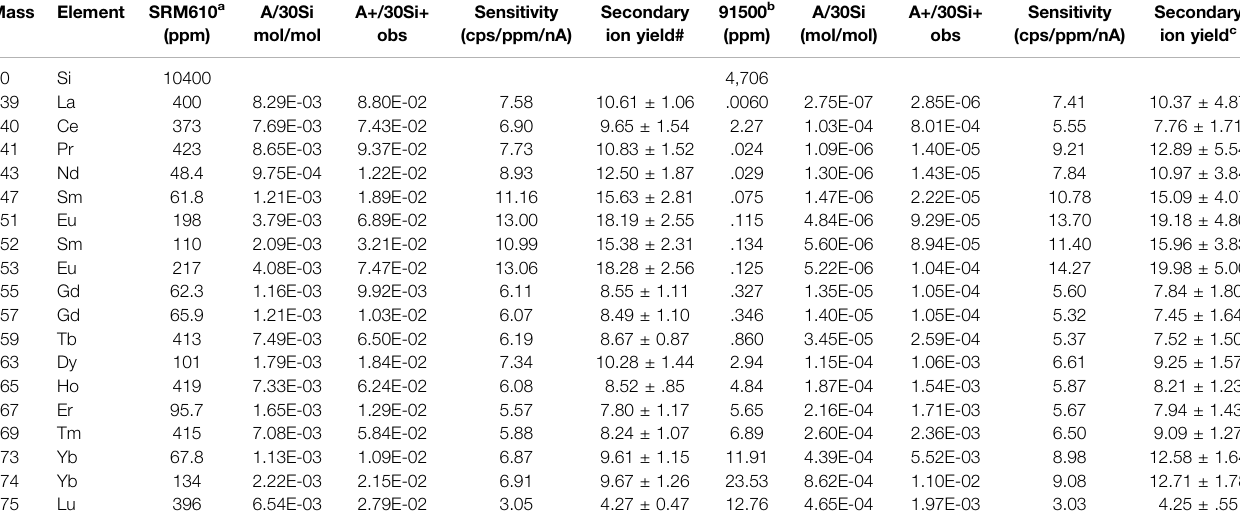
TABLE 2 | Observed sensitivities and secondary ion yields of rare earth elements in SRM610 glass and 91500 zircon Mass Element SRM610